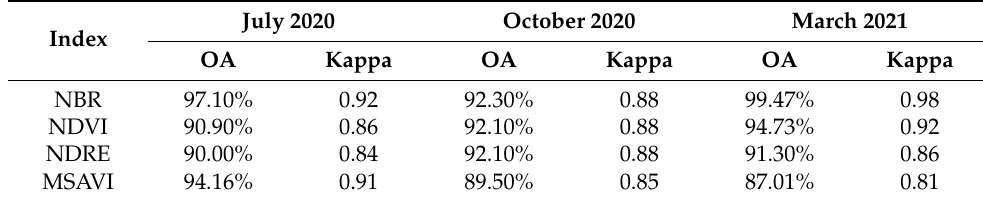
Table 4. Index classification accuracy.